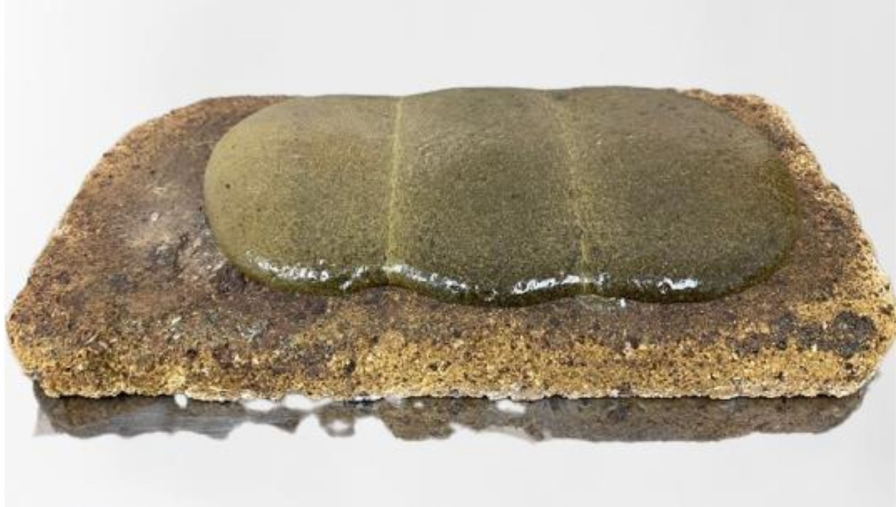
Figure 3. Samples with the addition of diatomite from the Utesai deposit after burning at a tempera- ture of 1200 ◦